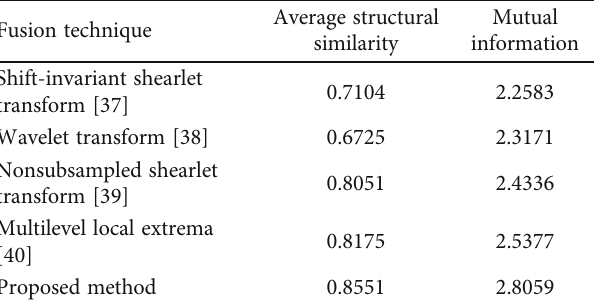
Table 2: Performance evaluation of the proposed approach. Fusion